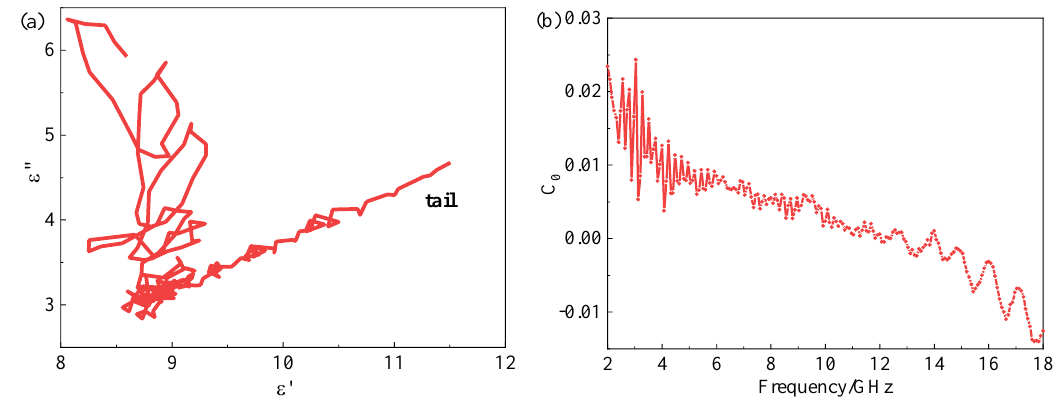
C value of the CB20 − CIP30 composite. Figure 10. ( a ) Cole-Colo curve, ( b ) C 0 value of the CB20-CIP30 0